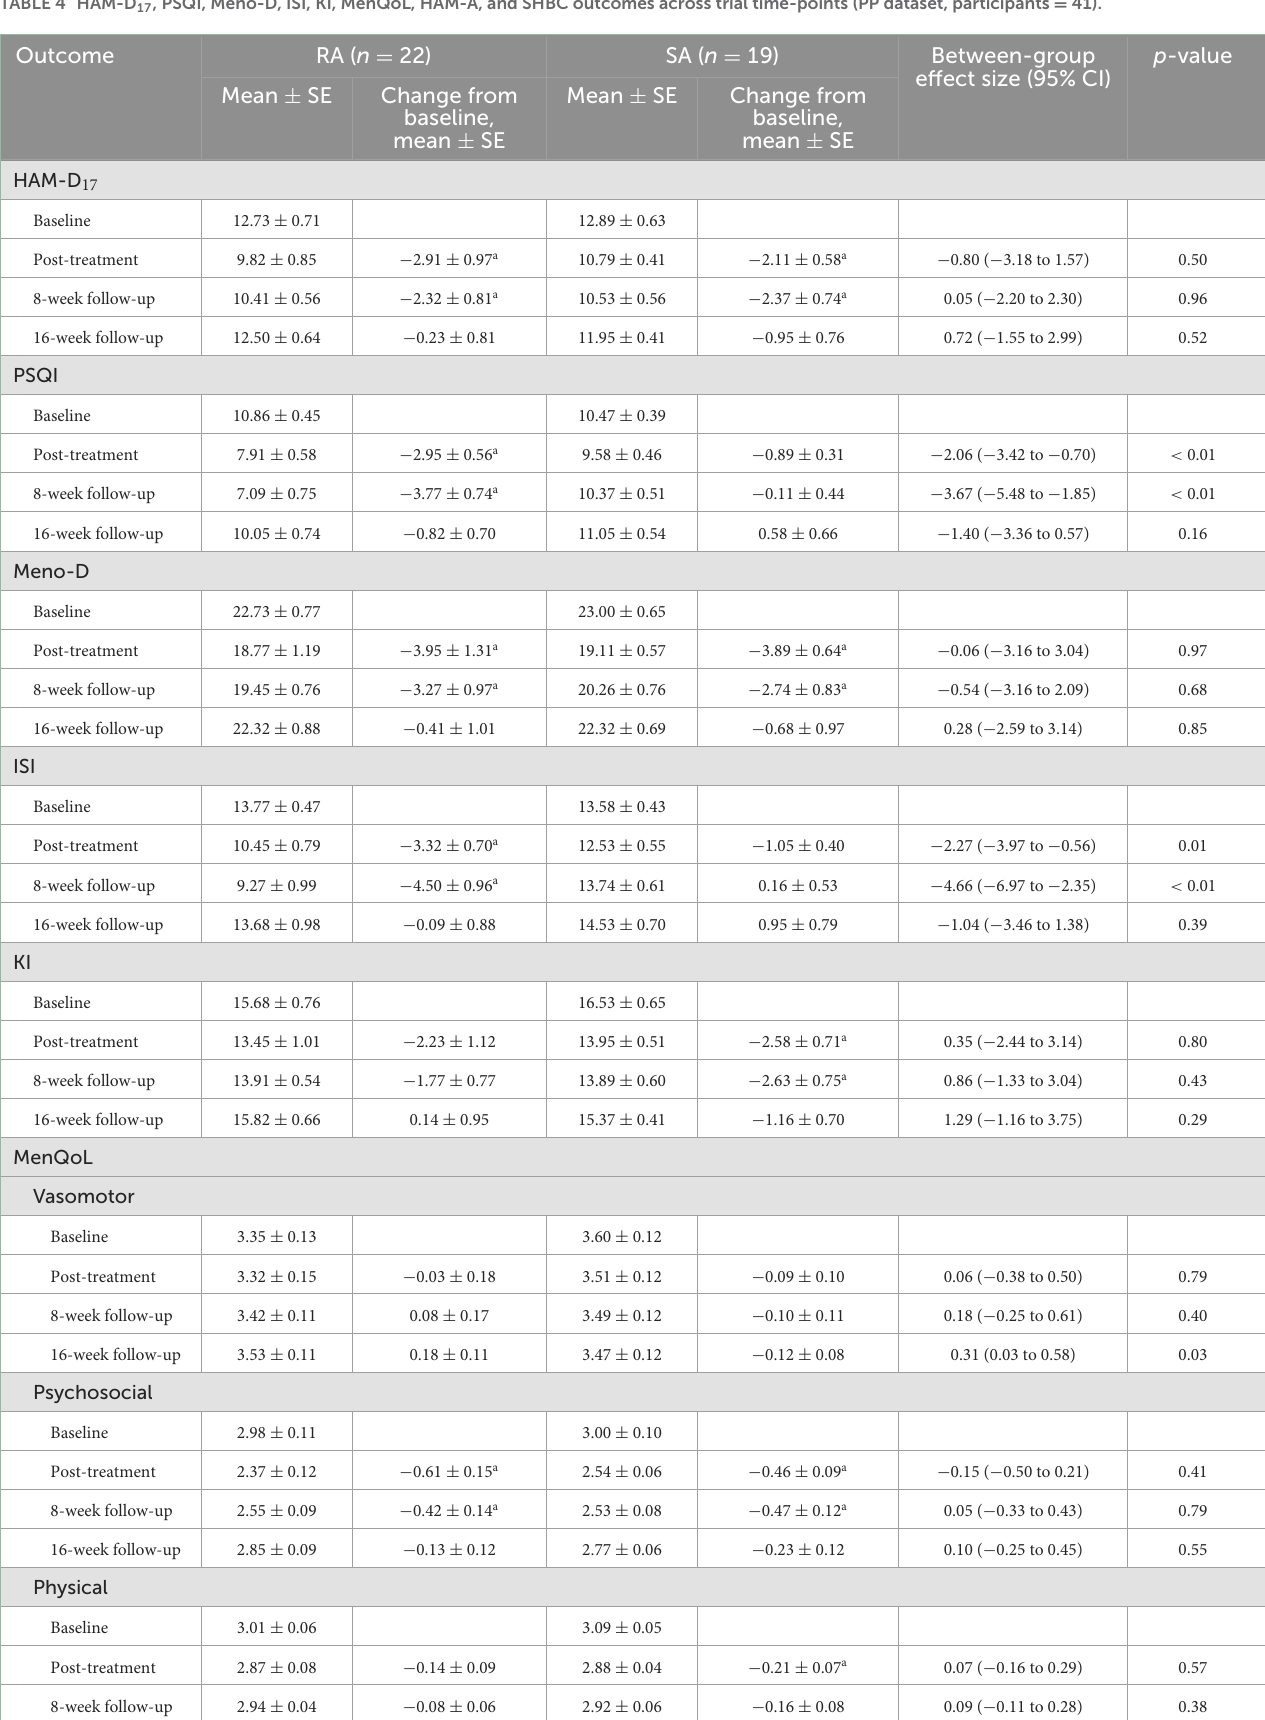
TABLE 4 HAM-D 17 , PSQI, Meno-D, ISI, KI, MenQoL, HAM-A, and SHBC outcomes across trial time-points (PP dataset, participants = 41). Outcome RA ( n = 22) SA ( n = 19) Between-group